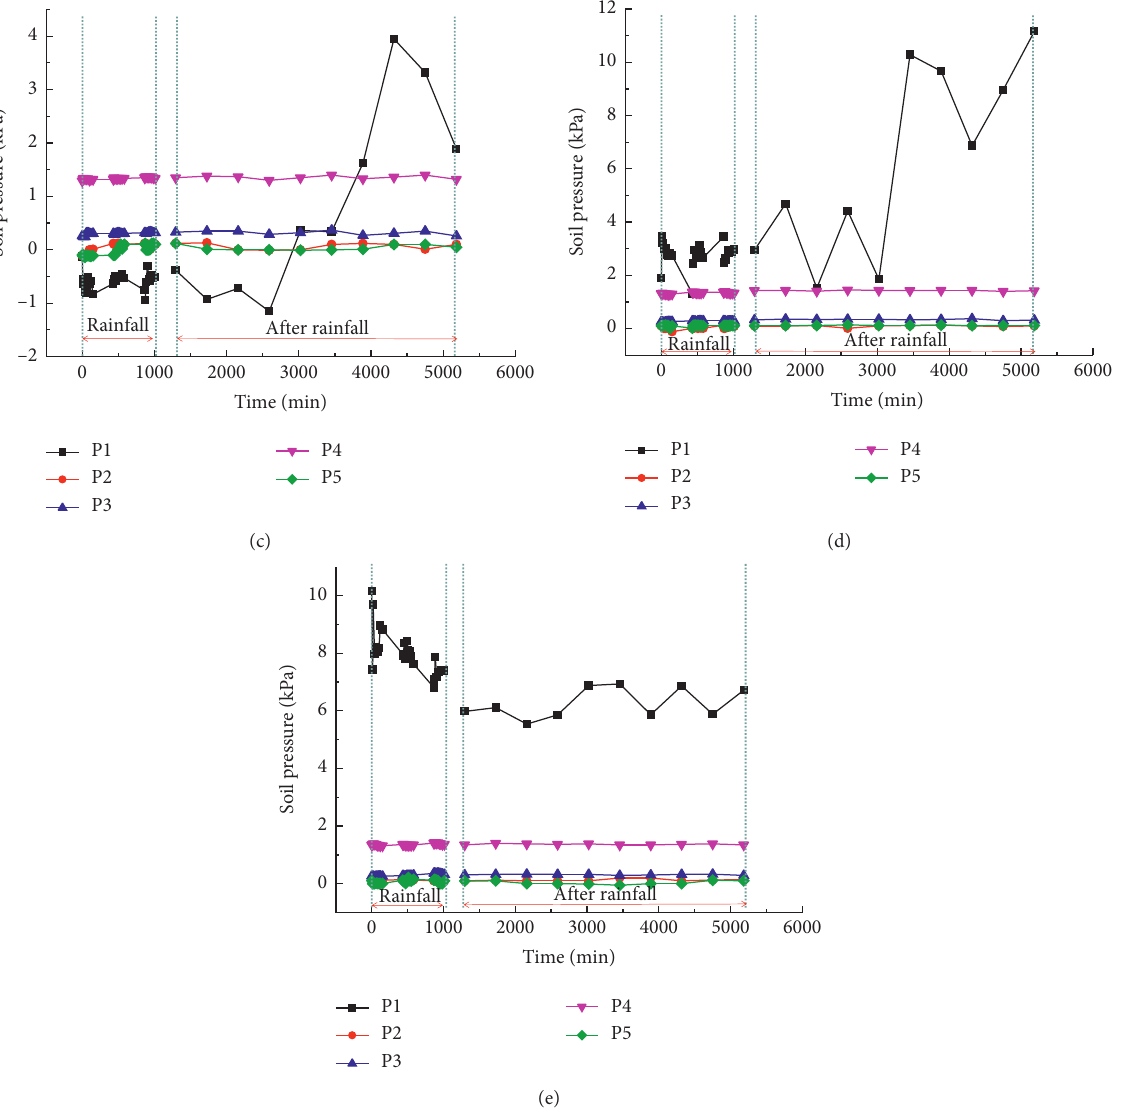
Figure 13: Variations of soil pressure upon the retaining wall back. (a) First year. (b) Second year. (c) Third year. (d) Fourth year. (e) Fifth